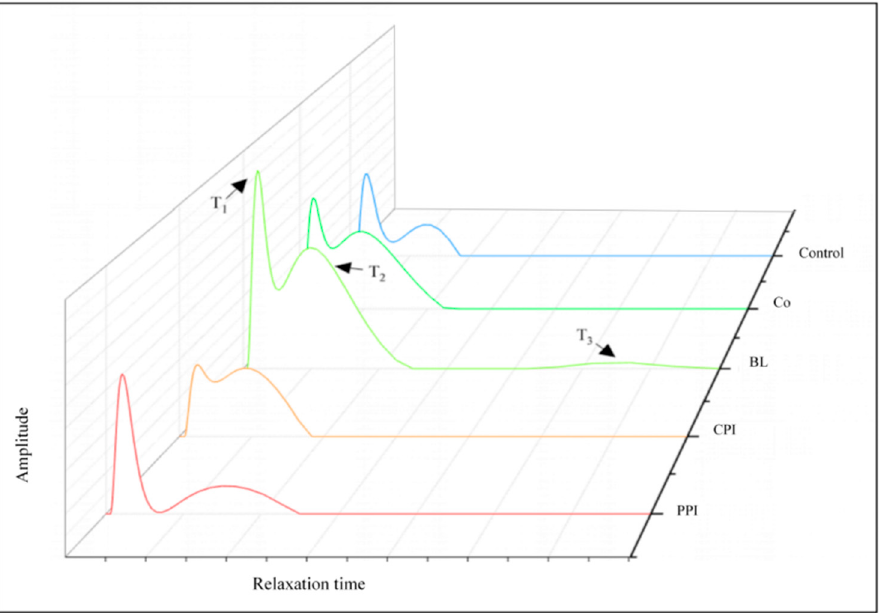
Figure 6. Effects of different protein pre-emulsified soybean oil on water distribution of fish sausage.